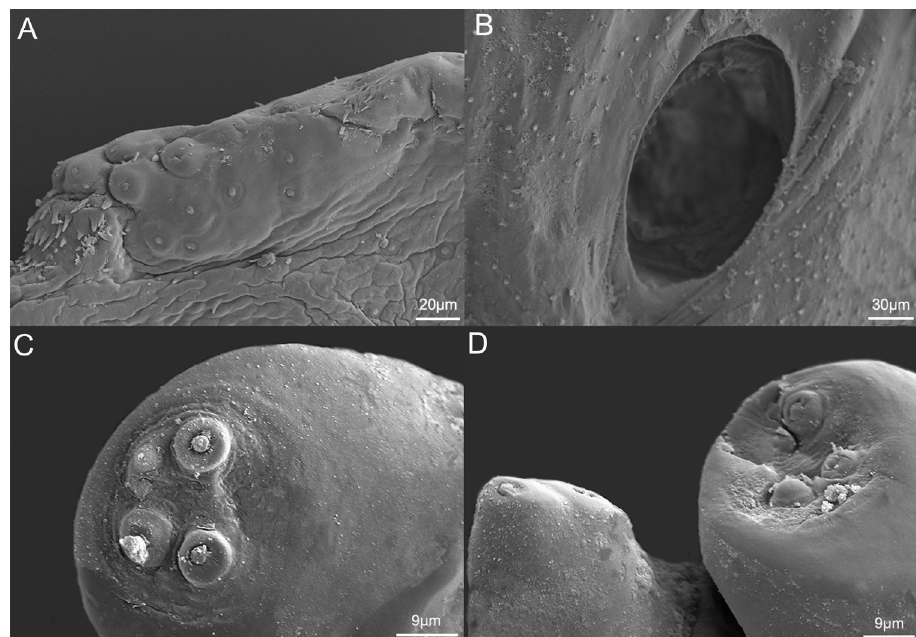
Figure 9. Ultrastructures of Vespula structor (Smith) (scanning electron micrographs). A Left half of labrum, ventral view, showing minute setae and conical papillae B spiracle C labial palpi with four apical sensilla D maxillary palp with three apical sensilla (sometimes four), galea with two apical sensilla. Pupa. Average length of body approx. 16.0 mm and 5.5 mm wide ( n = 5);